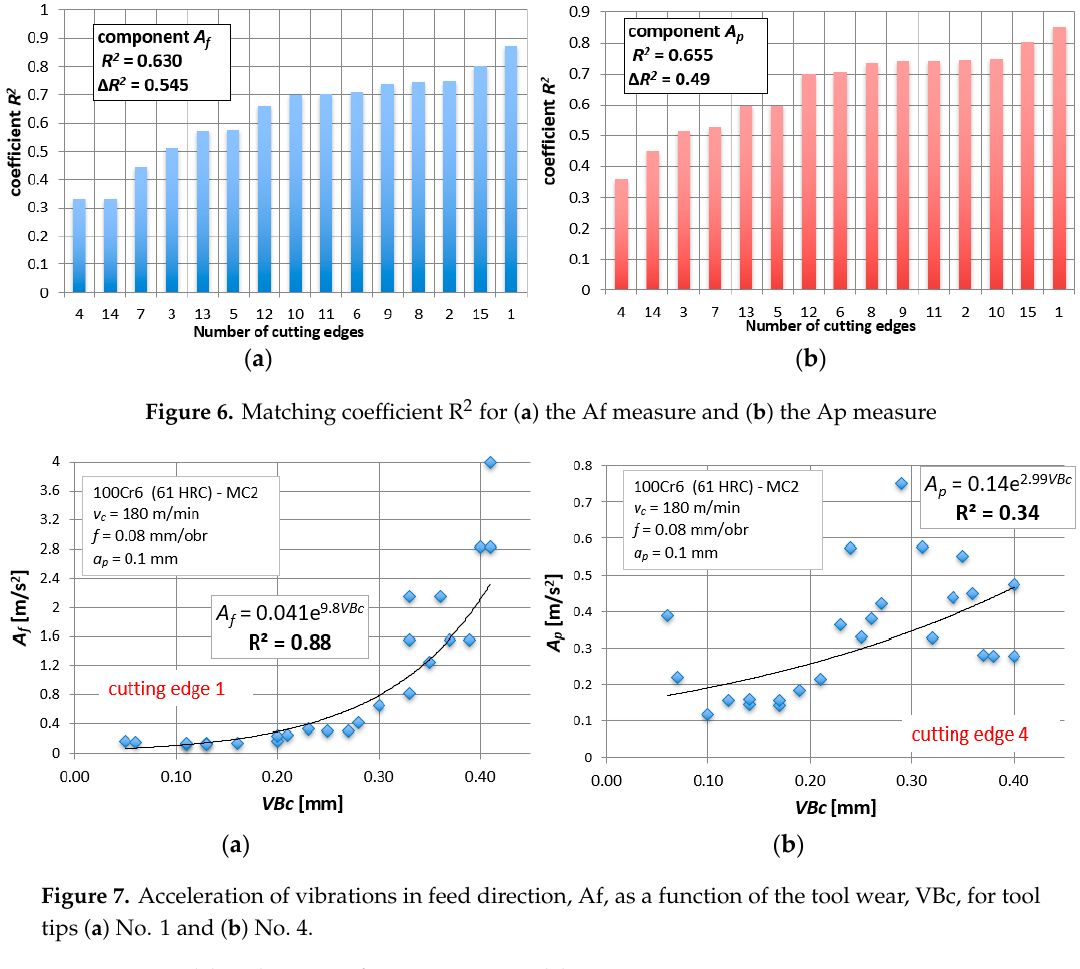
( b ) Figure 5. Cutting force, Fp_max, as a function of the tool wear, VBc, for tool tip ( a ) No. 4 and ( b ) No. 6 . The dependencies based on accelerations of vibrations look different and the dispersions of